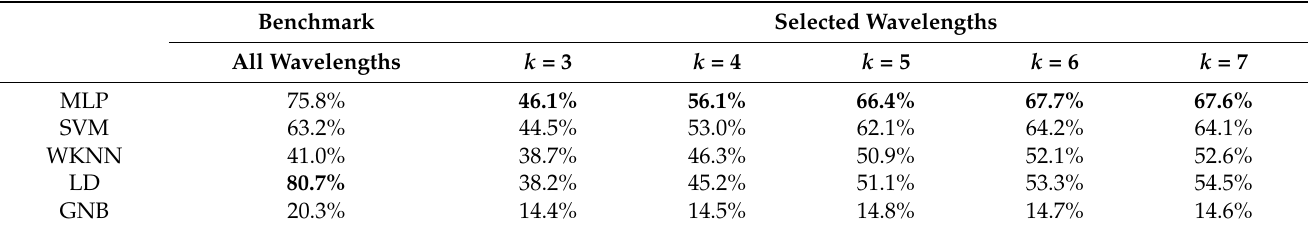
Table 5. Single-mode classification accuracies (4-fold cross-validation) for the SWIR